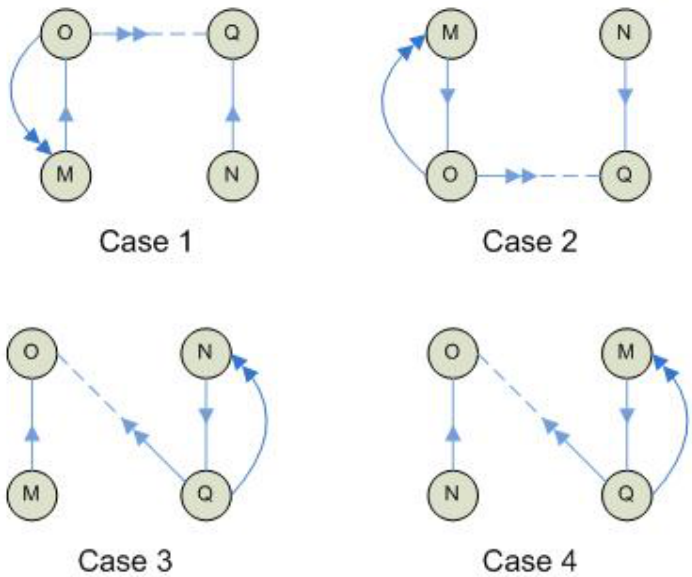
Figure 3. Collision between nodes N and M having the same color with two-hop coloring and immediate acknowledgement in a